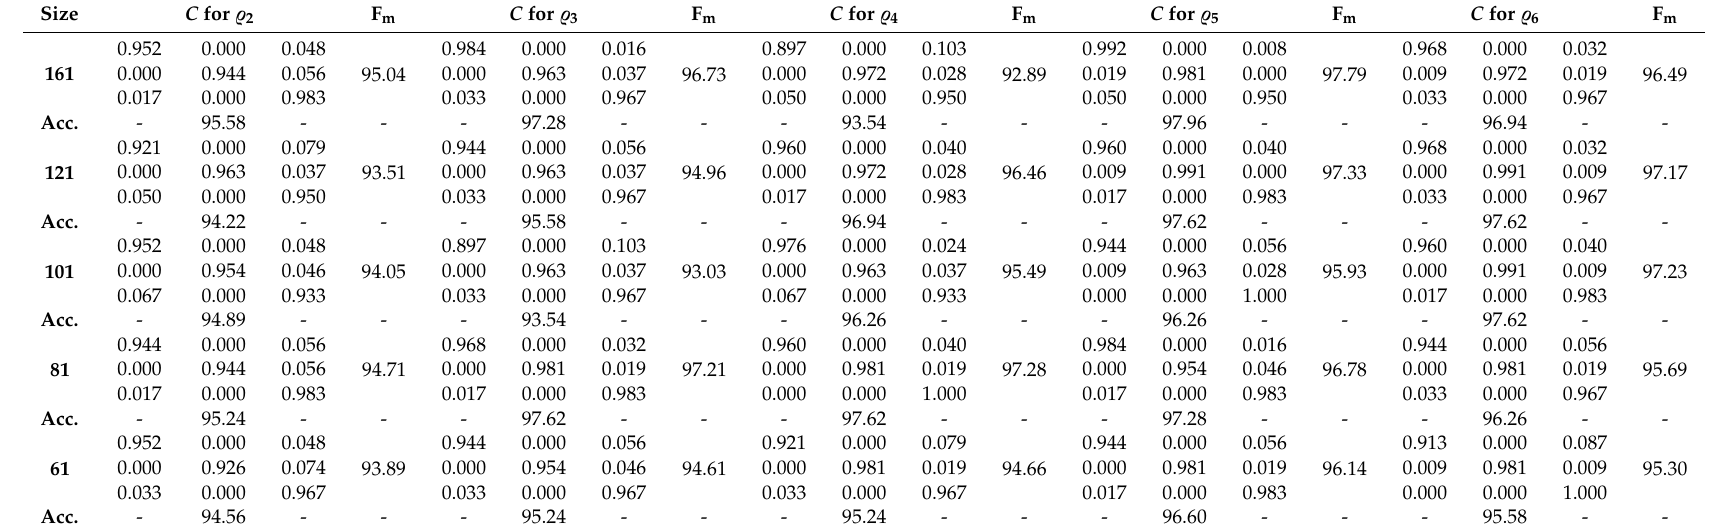
Table 7. Performance of the linear discriminant analysis (LDA) classifier for di ff erent combinations of textural